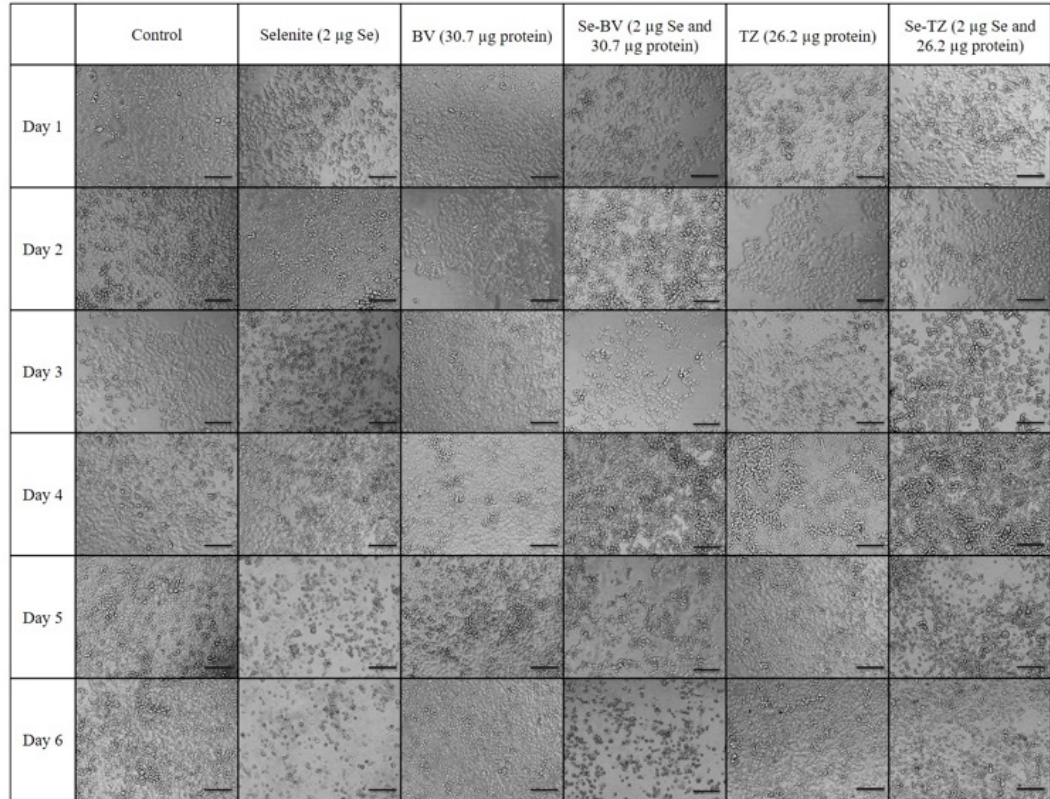
Figure 9. Photomicrographs of the morphological changes observed in control, Selenite, Bevacizumab (BV), Selenobevacizumab (Se-BV), Trastuzumab (TZ) and Selenotrastuzumab-treated HME 50-5E Cells. Treatment of HME 50-5E cells with Selenite, Se-BV and Se-TZ did not induce severe morphological cell changes in comparison to those seen in the selenium-treated MDA-MB-468 cells. Representative fields of view of HME50-5E cells. Cells were photographed under phase contrast conditions at 20× magnification. Scale bar = 100 µm.